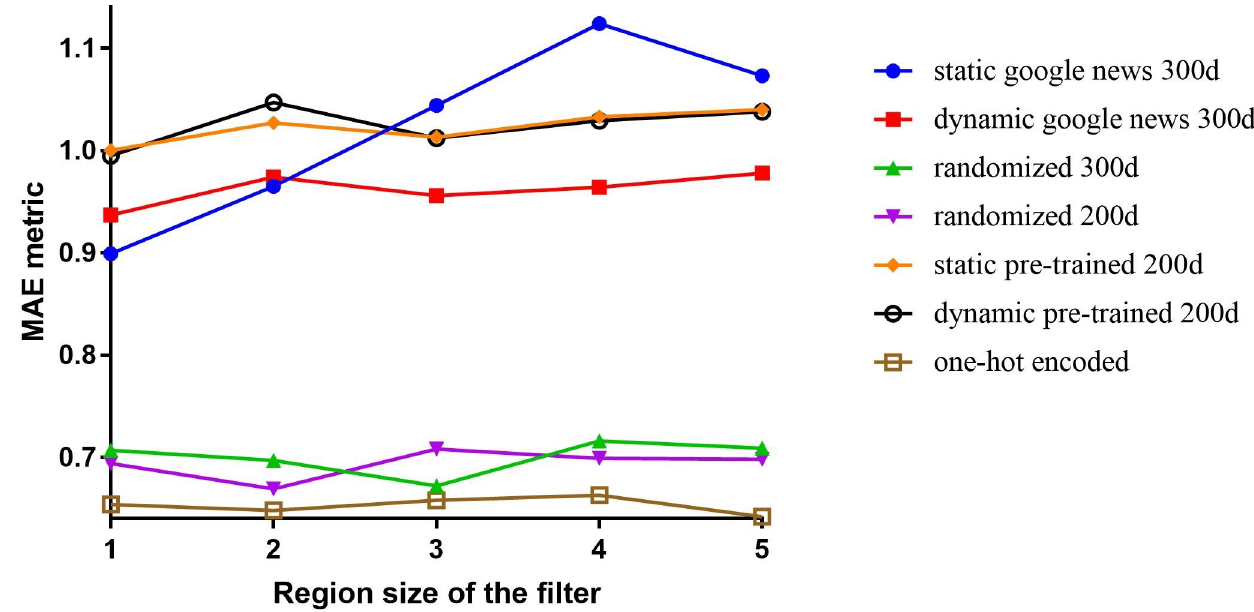
Fig 4. Effect of different input representations with different filter region sizes.